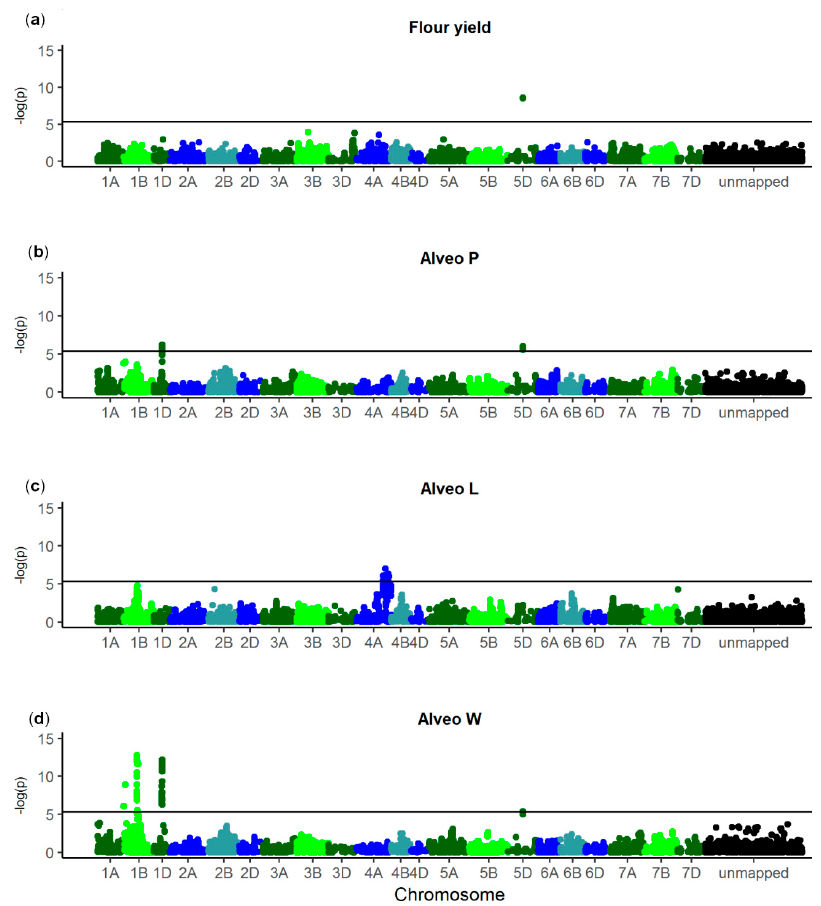
Figure 3. Manhattan plots of − log 10 ( p -values) after correction with the genomic inflation factors. ( a ): Flour yield, ( b ): Alveo P, ( c ): Alveo L, ( d ): Alveo W. The horizontal lines show the Bonferroni corrected significance threshold. Total number of single nucleotide polymorphisms (SNPs): 10,802. Last bin is unmapped SNPs.